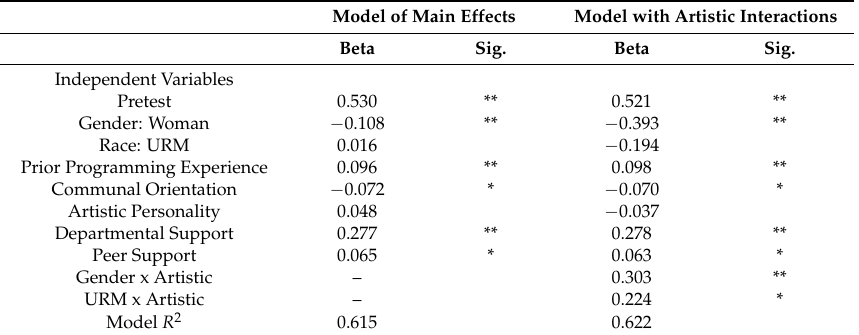
Table 4. Main Effects and Interaction Effects Models Predicting Sense of Belonging ( n =